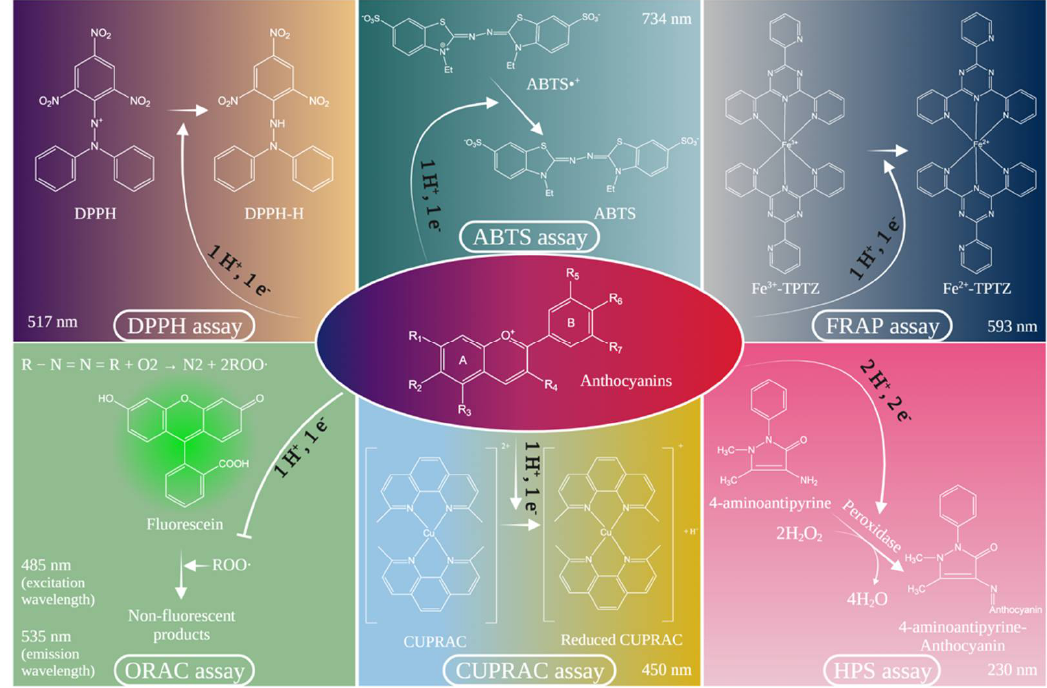
Figure 3. The action mechanism of methods for evaluating antioxidant activity.